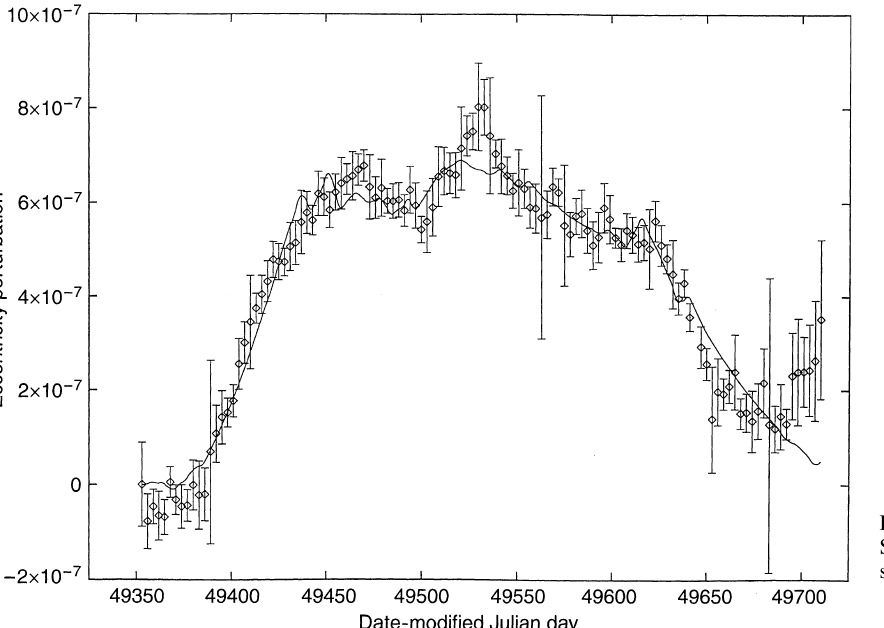
Fig 5. The change in eccentricity of Stella due to ocean tides from the simultaneous fitting